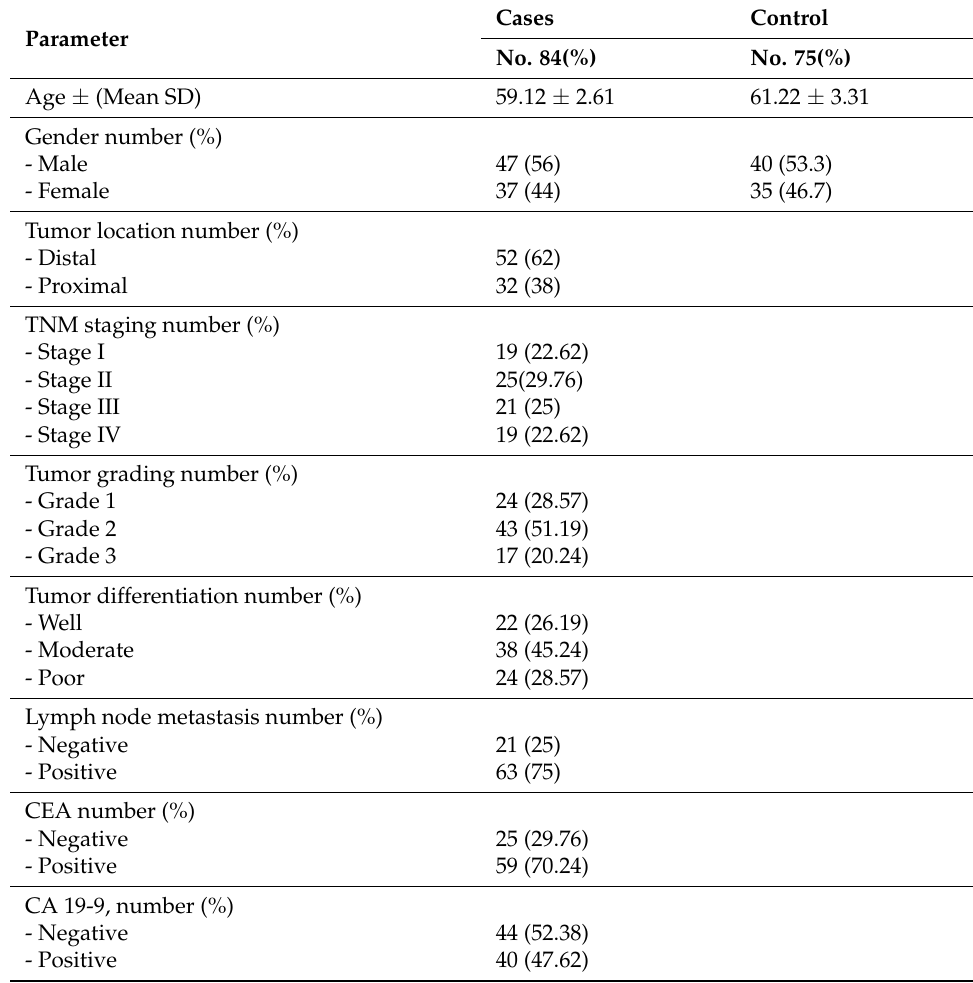
Table 1. Clinicopathological features of the studied